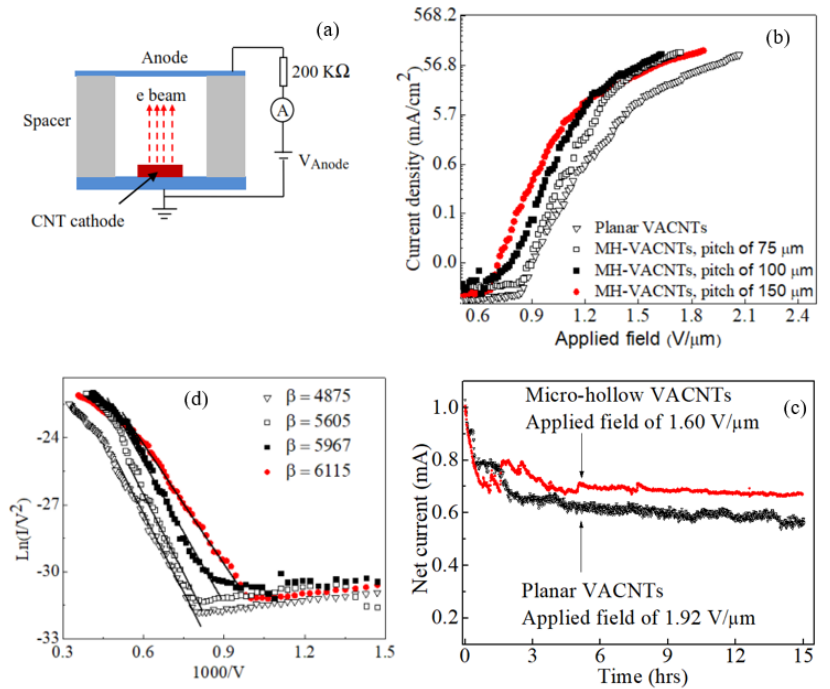
Figure 3. ( a ) Schematic of the field emission setup; ( b ) Current density–applied field (J–F) curves